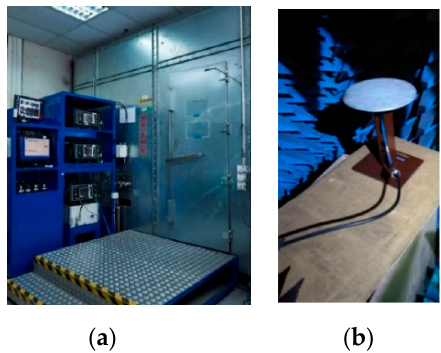
Figure 28. ( a ) The PIM measurement system with both the PIM Analyzer and PIM chamber. ( b ) The antenna under test inside the PIM chamber.